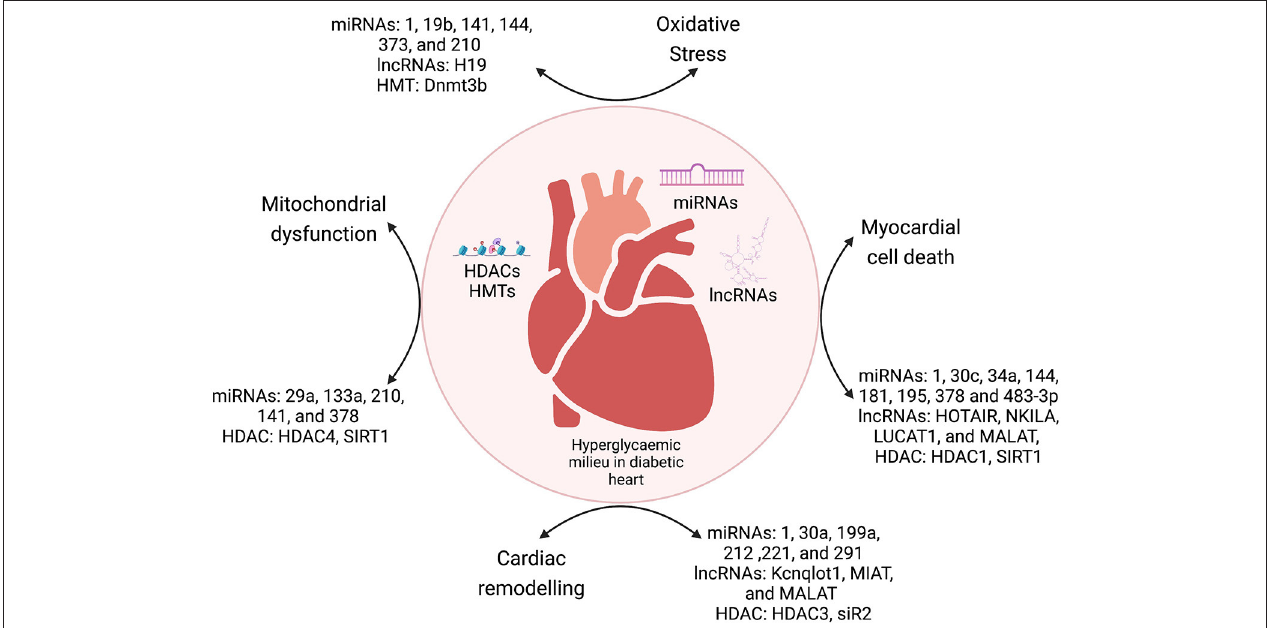
FIGURE 3 | The crosstalk between epigenetic modulators and various mechanisms of DbCM. miRNAs, microRNAs; lncRNAs, long non-coding RNAs; HDACs, histone deacetylases; HMTs, histone methyltransferases; DNMT, DNA methyltransferases.